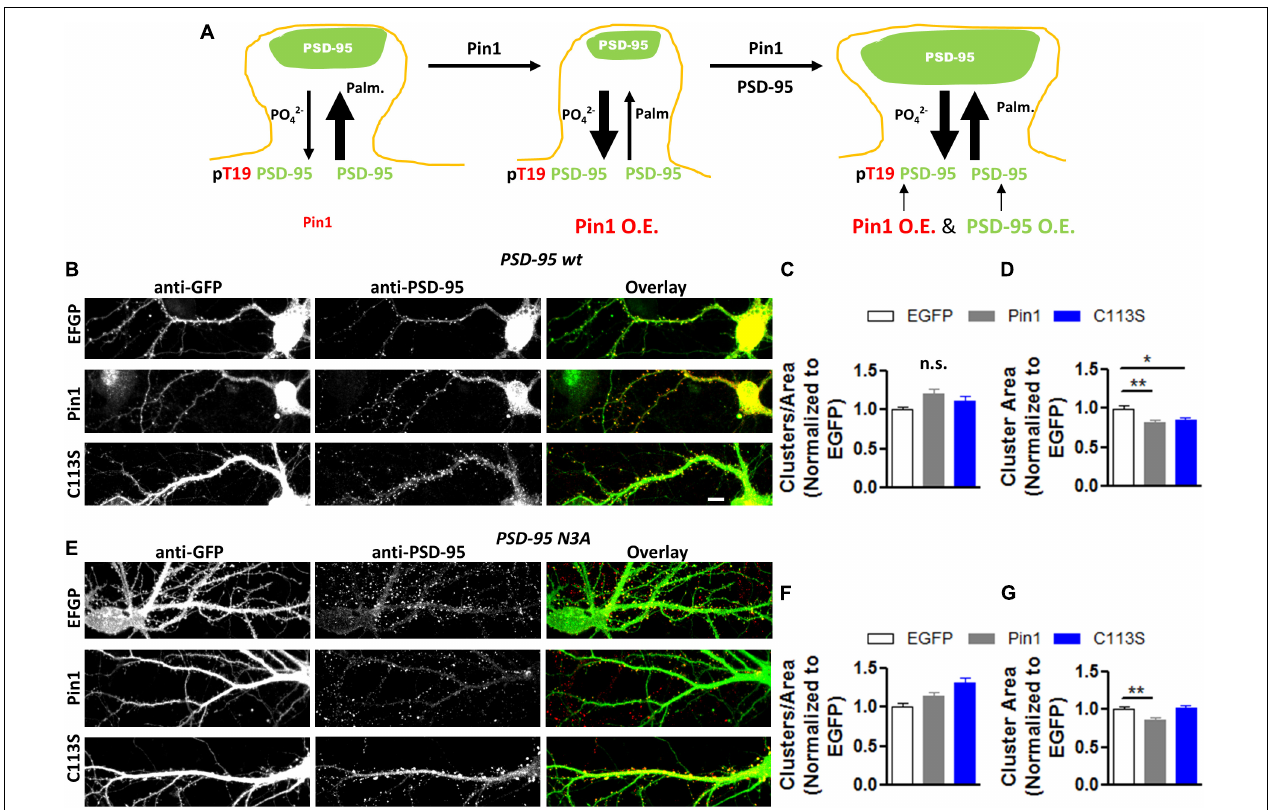
FIGURE 8 | PSD-95 restores the decrease in PSD-95 cluster number induced by Pin1. (A) Model showing how post-translational modification regulates PSD-95 entry and stability at the PSD. (B) Confocal images of hippocampal cultured neurons overexpressing PSD-95 and control or Pin1 IRES EGFP. Images show EGFP, PSD-95 staining and the overlay image. Scale bar: 10 µ m. (C) wt PSD-95 restores the decrease in cluster number. Normalized number of clusters for dendrites expressing EGFP EGFP 1.00 ± 0.04, n = 49; Pin1 1.21 ± 0.07, n = 53; C113S 1.12 ± 0.07, n = 54, (D) PSD-95 overexpression restores the area of PSD-95 clusters well above the level of non-transfected. EGFP 1.00 ± 0.04, n = 49; Pin1 0.82 ± 0.04, n = 53, C113S 0.85 ± 0.03, n = 55 Kruskal–Wallis chi-square = 13.46, df = 2, p < 0.0012. (E) Similar to wt PSD-95, overexpression of the N3A mutant of PSD-95 also restores to control levels the density of PSD-95 per dendritic area in cells overexpressing Pin1. (F) N3A overexpression restores the cluster of PSD-95 per dendritic area above the level of EGFP expressing cells. EGFP 1.00 ± 0.04, n = 42; Pin1 0.14 ± 0.05, n = 66; C113S 1.32 ± 0.06, n = 51, One-way ANOVA F (2,156) = 7.84, p = 0.0006. (G) N3A overexpression